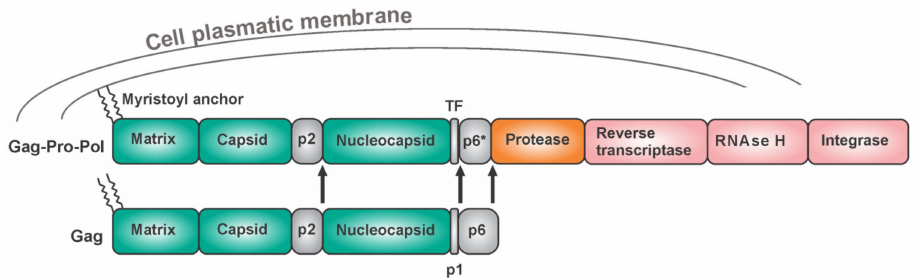
Figure 4. Retroviruses: Gag and Gag-Pol polyprotein of HIV-1 with its N-terminal myristoyl mem- brane anchor. The ratio of the Gag and Gag-Pol molecules is precisely regulated by the frequency of frameshift events. The arrows indicate the initial cis-cleavage